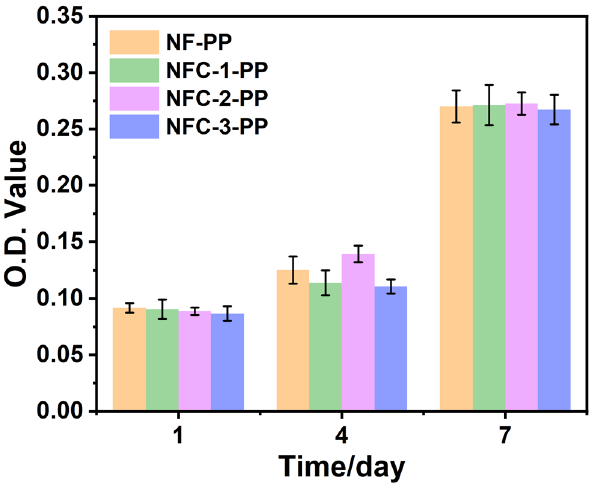
Figure 10: Cell proliferation assay for BMSC seeding on NF - PP and NFC - PP with di ff erent CIP concentrations for di ff erent